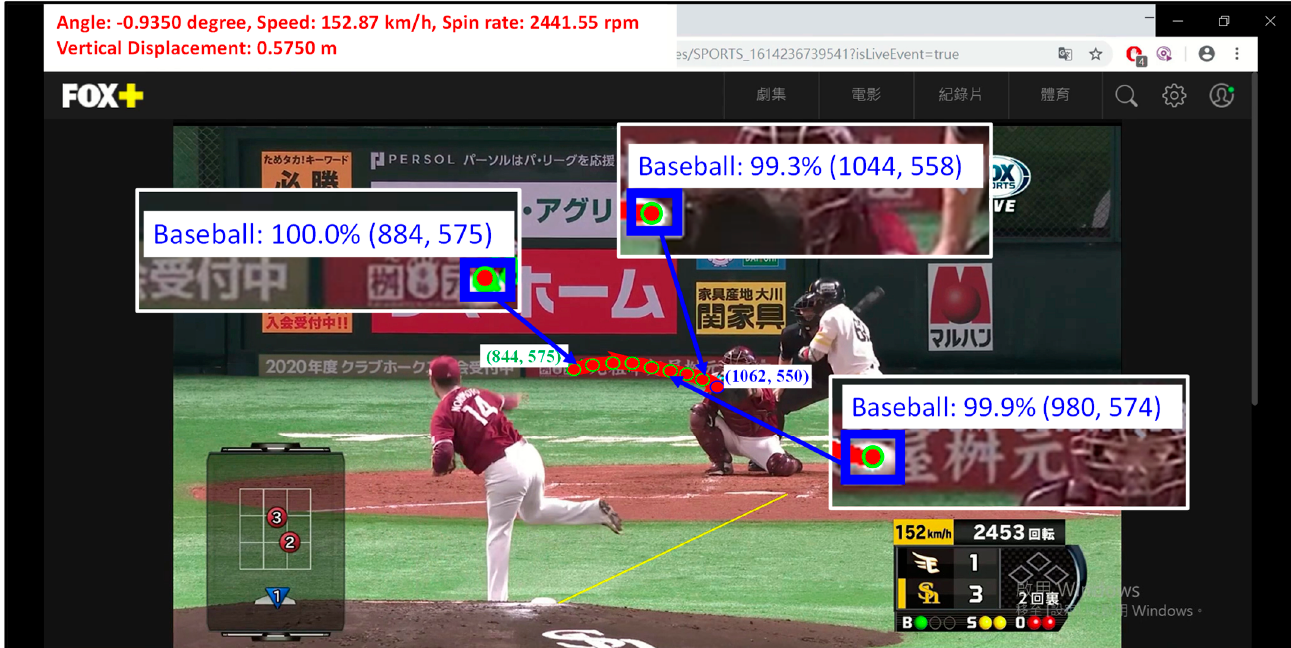
Figure 8. Automatic measurement result for a four-seam fastball.